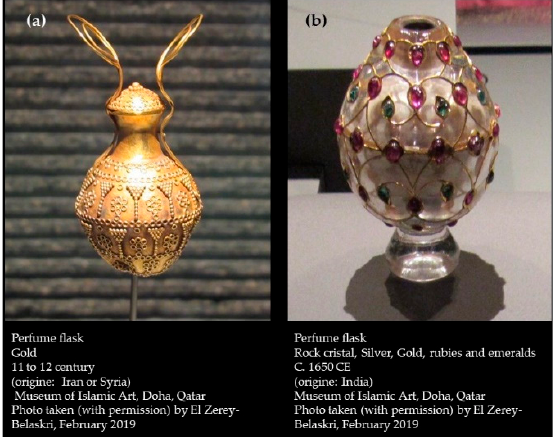
Figure 1. Ancient perfume flasks witnessing the luxury of fragrance bottles: ( a ) perfume flask in gold, decorated with a bold geometric pattern; ( b ) perfume flask in rock crystal, decorated with gold, silver, and precious gemstones, rubies and emeralds. Conservation: Museum of Islamic Art, Doha, Qatar. Personal photos taken by the first author with permission. February 2019.